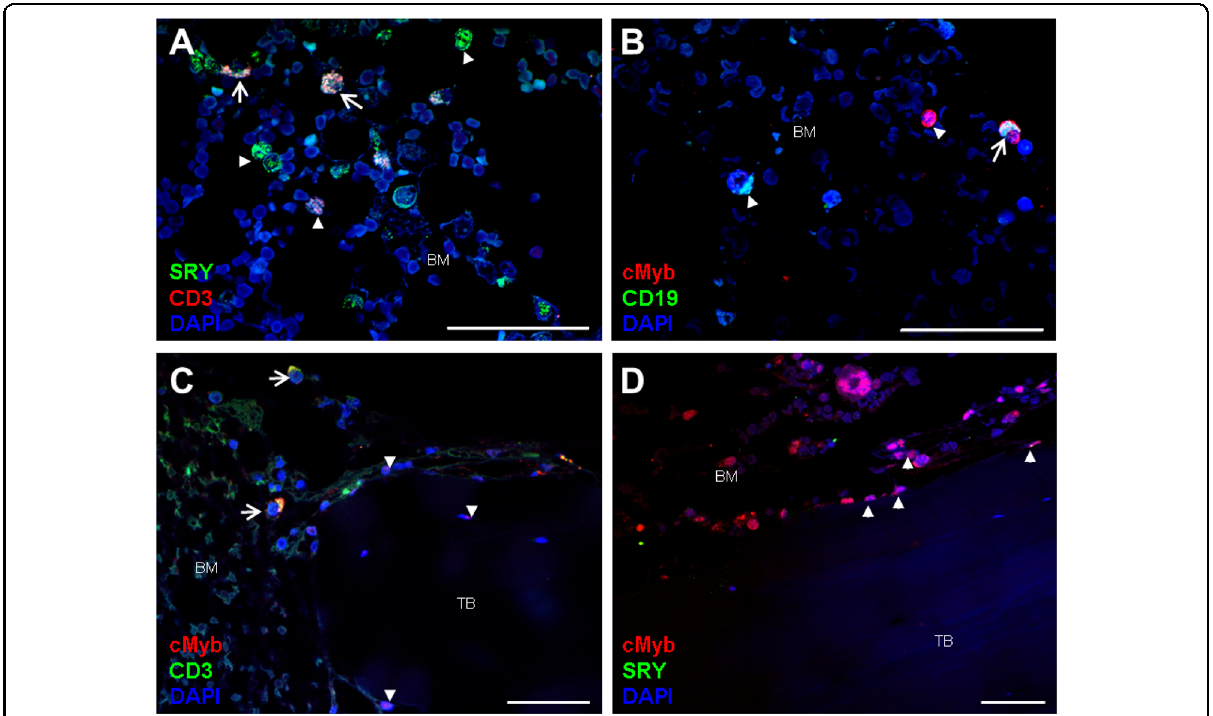
Fig. 6 Colocalization of SRY and cMyb with T-lymphocyte and B-lymphocyte markers in human bone tissue. a Bone tissue of a male patient with osteoporotic fracture showing costaining of SRY with the T-lymphocyte marker CD3 (arrow) in bone marrow (BM) cells. Double-positive cells (arrows) and single-positive cells for SRY or CD3 (arrowhead) are observed within bone marrow cells. b Bone tissue of a male patient with osteoporotic fracture showing costaining of cMyb with the B-lymphocyte marker CD19. Double-positive cells (arrow) and single-positive cells for cMyb or CD19 (arrowhead) are observed within bone marrow (BM) cells. c Bone tissue of a male patient with osteoporotic fracture showing costaining of cMyb with the T-lymphocyte marker CD3 (arrow) in bone marrow (BM) cells. Double-positive cells (arrows) are observed within bone marrow cells. Single-positive cells for cMyb (arrowhead) are observed within bone marrow cells, on the trabecular bone (TB) surface, and in a few osteocytes. d Bone tissue of female patients with osteoporotic fracture showing negative staining for SRY and similar patterns of cMyb staining as in the male osteoporotic fracture tissue. Scale bars: 50